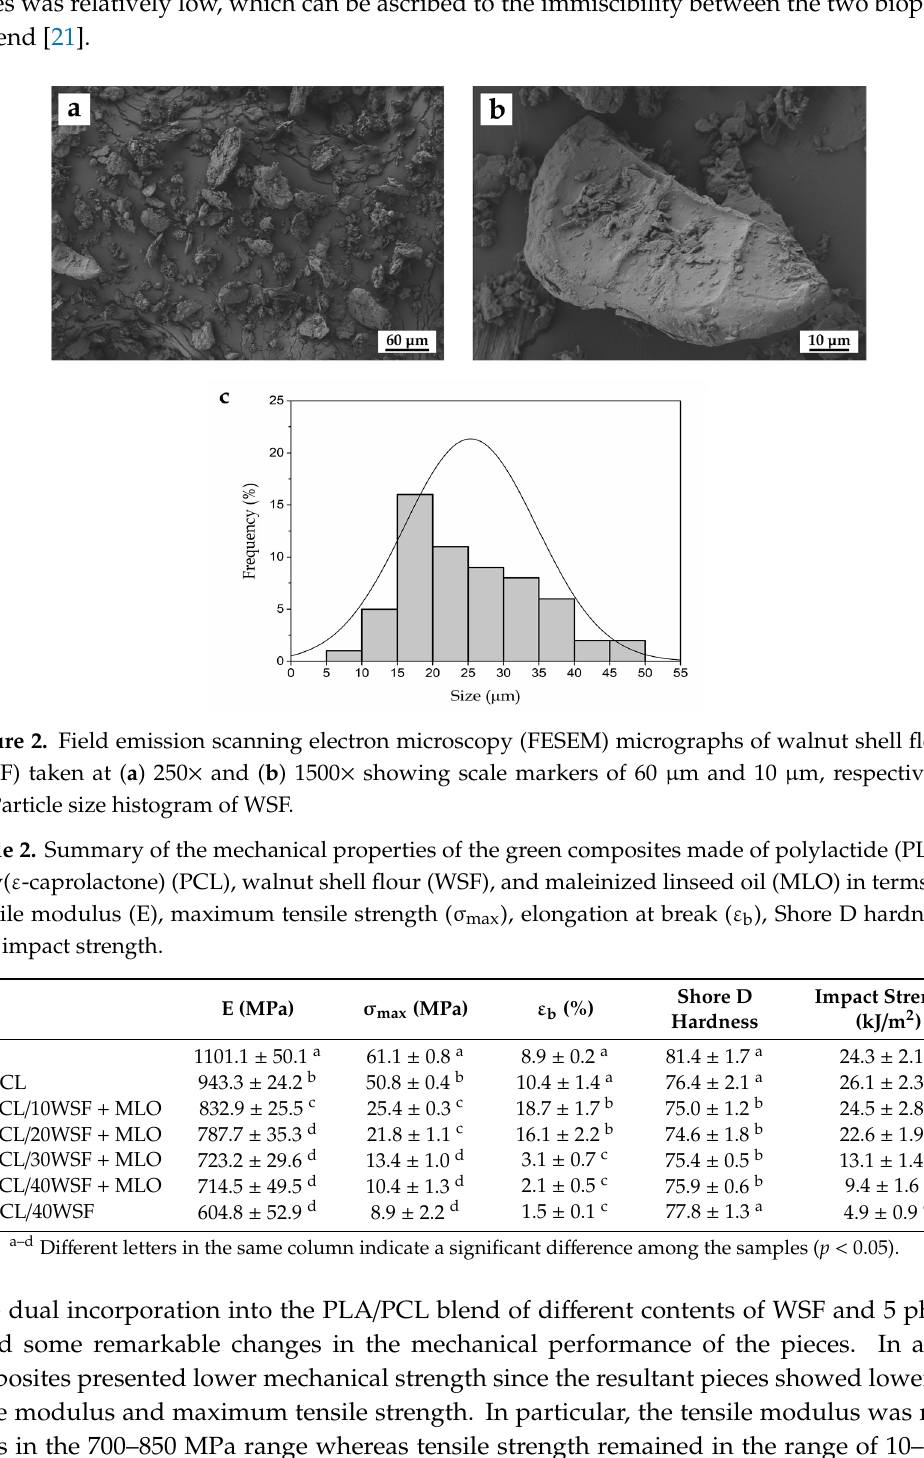
Table 2. Summary of the mechanical properties of the green composites made of polylactide (PLA), poly( ε‐ caprolactone) (PCL), walnut shell flour (WSF), and maleinized linseed oil (MLO) in terms of: tensile modulus (E), maximum tensile strength ( σ max ), elongation at break ( ε b ), Shore D hardness, and impact strength.